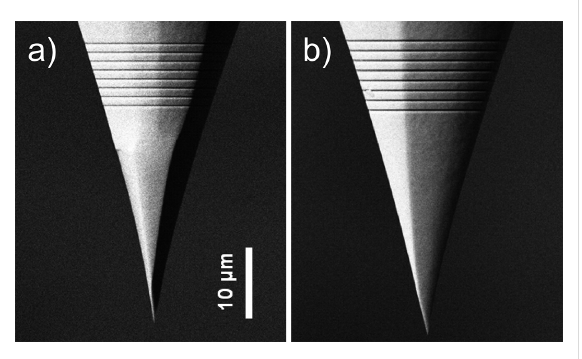
Figure 1: Scanning electron micrographs of two gold tapers that were obtained by electrochemical AC-etching of annealed gold wires fol- lowed by focused ion beam milling of the grating couplers. Field enhancement at the taper apex was much more pronounced for the tip shown in panel